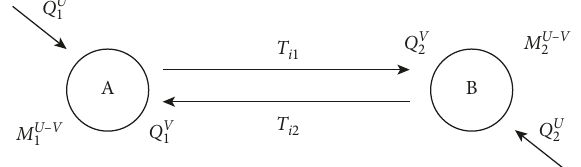
Figure 13: A two-node disaggregate market.